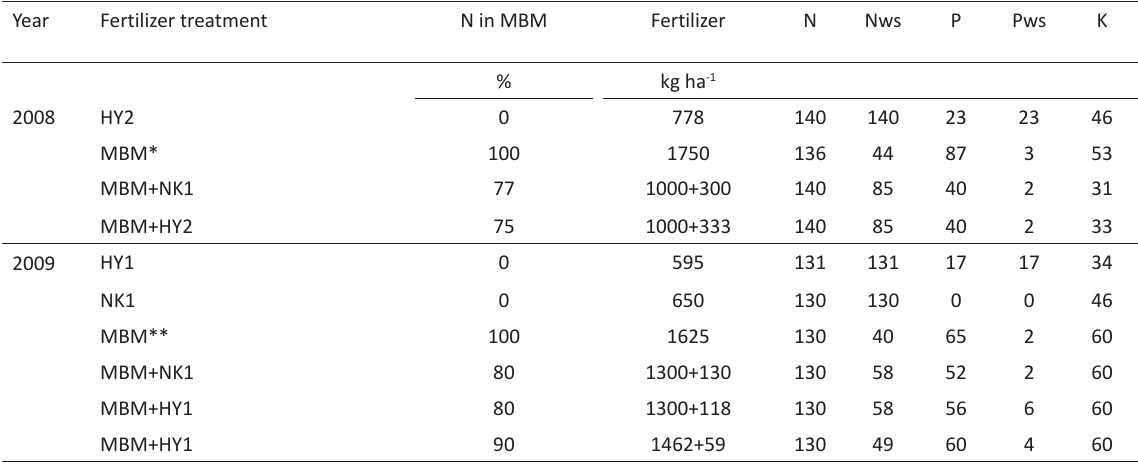
Table 5. Rates of fertilizer applications (kg ha -1 ) and N, P, and K applied for the sugar beet in 2008 and 2009